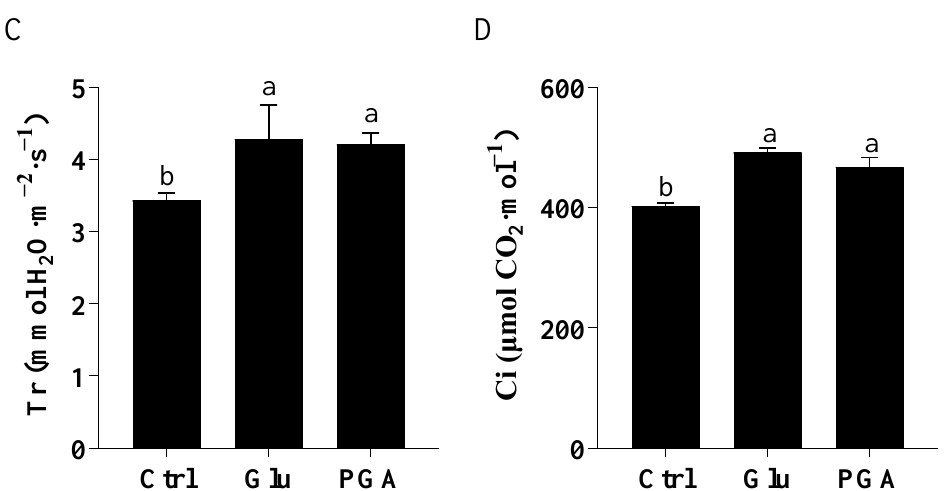
Figure 3. Effect of Glu and γ -PGA on gas exchange parameters in Chinese cabbage under heat stress. Pn ( A ), Gs ( B ), Tr ( C ), Ci ( D ). Data are shown as mean ± SD of three replicates. Different lowercase letters indicate significant differences at p < 0.05.